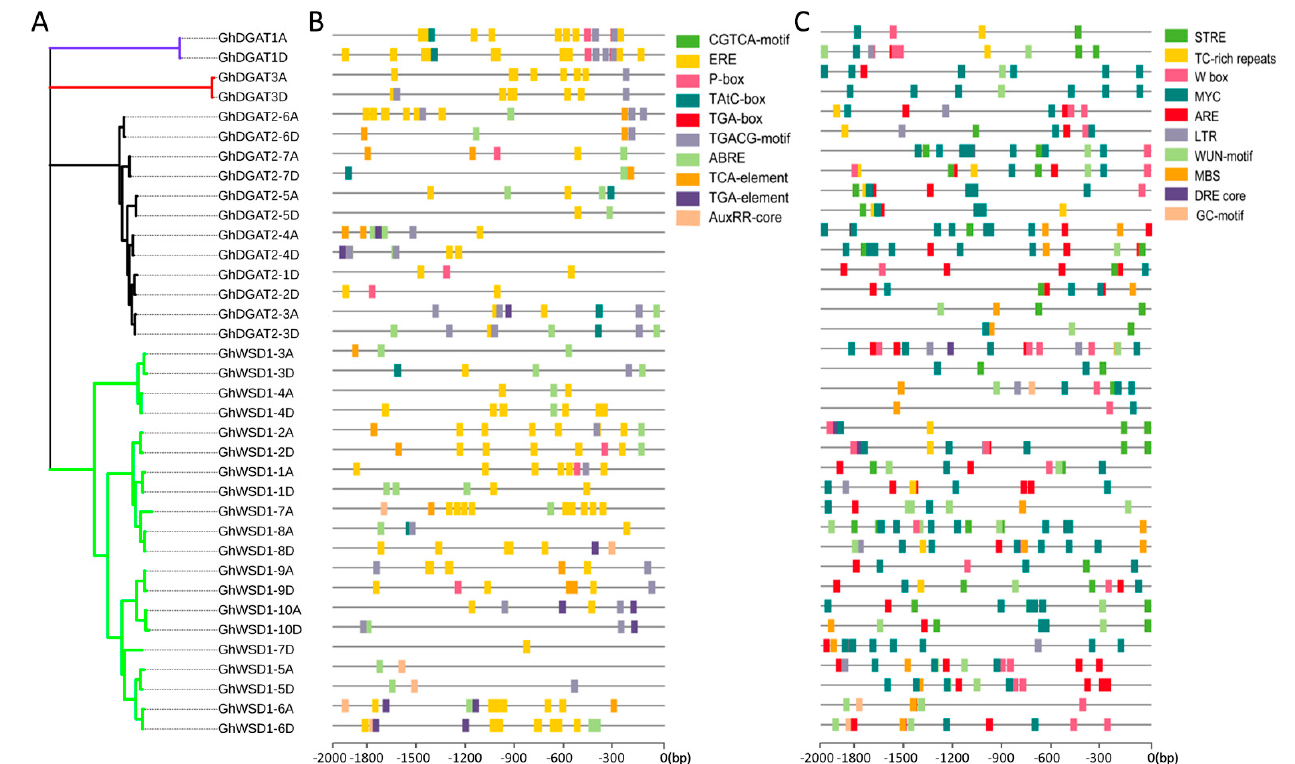
Figure 5. cis -elements in GhDGAT and GhWSD1 promoter regions; ( A ) phylogenetic tree of GhDGAT and GhWSD1 proteins; ( B ) predicted cis-elements involved in plant hormones. ABRE: cis-acting element involved in abscisic acid responsiveness; AuxRR-core: cis-acting regulatory element involved in auxin responsiveness; AuxRE: part of an auxin-responsive element; CGTCA-motif: cis-acting regulatory element involved in MeJA-responsiveness; GARE-motif: gibberellin-responsive element; TGACG-motif: cis-acting regulatory element involved in MeJA-responsiveness; TGA-element: auxin-responsive element; TGA-box: part of auxin-responsive element; ERE: cis-acting ethylene responsive element; P-box: gibberellin-responsive element; ( C ) predicted cis-elements involved in environmental stress responses. GC-motif: enhancer-like element involved in anoxic specific inducibility; LTR: cis-acting element involved in low-temperature responsiveness; MBS: MYB binding site involved in drought-inducibility; STRE: stress response element; TC-rich repeats: cis-acting element involved in defense and stress responsiveness; WUN-motif: wound-responsive element; MYC: cis-acting element involved in drought stress; W box: cis-acting element involved in sugar metabolism and plant defense signaling; DRE core: dehydration-responsive element; ARE: cis-acting regulatory element essential for anaerobic induction.